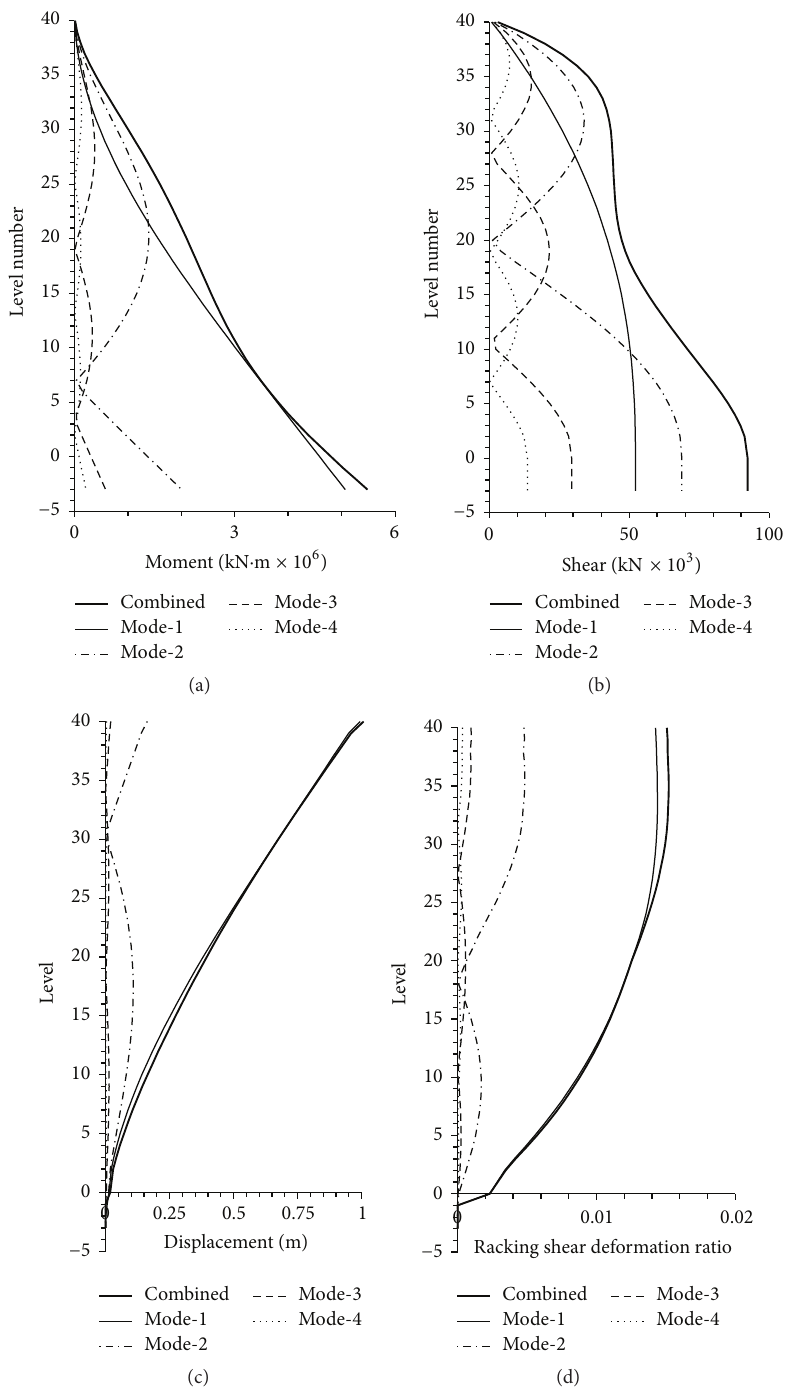
Figure3:DBEelasticmodalandtotalseismicdemands.(a)Momentdemands,(b)sheardemands,(c)displacementdemands,and(d)racking shear deformation